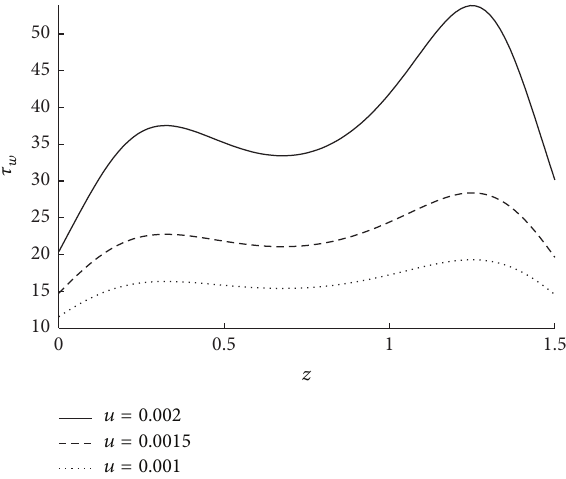
Figure 17: The variation of shear stress at wall in stenosed region with respect to 𝑢 when 𝑁 = 0.75 , 𝑟 𝑐 = 0.1 , 𝜖 = 0.1 , 𝑚 = 10 , and 𝜙 = −0.05